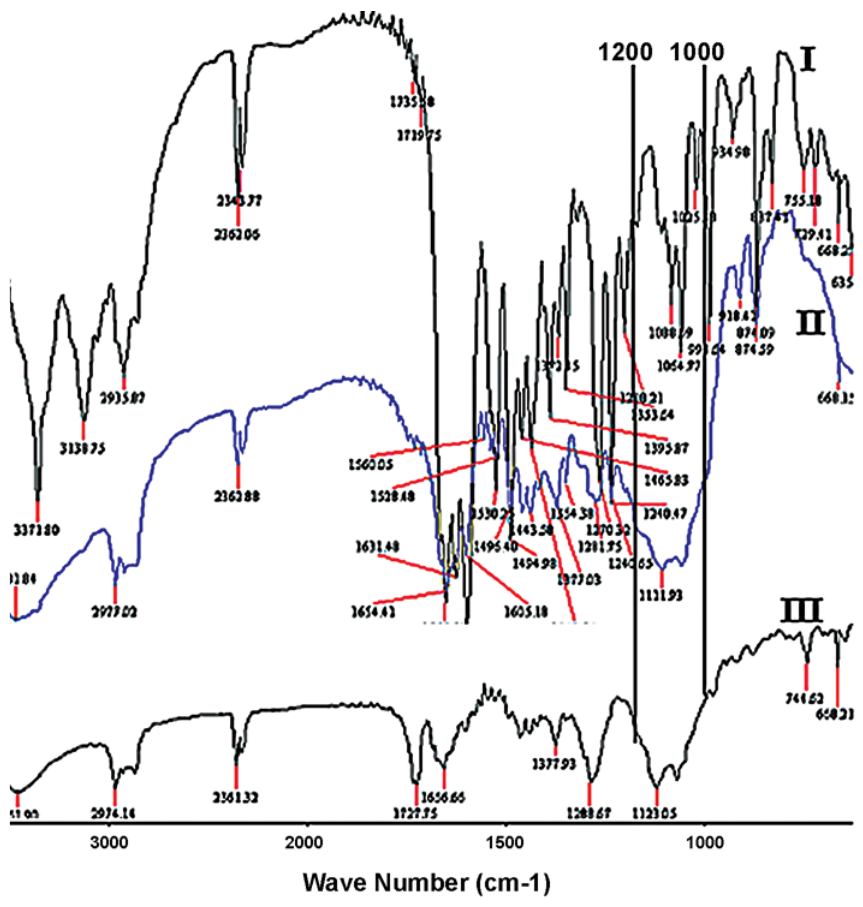
Figure 1 – FT IR spectra of alfuzosin hydrochloride (I); physical mixture of drug, ethyl cellulose and PVP (II) and transdermal film containing drug and polymers (III).